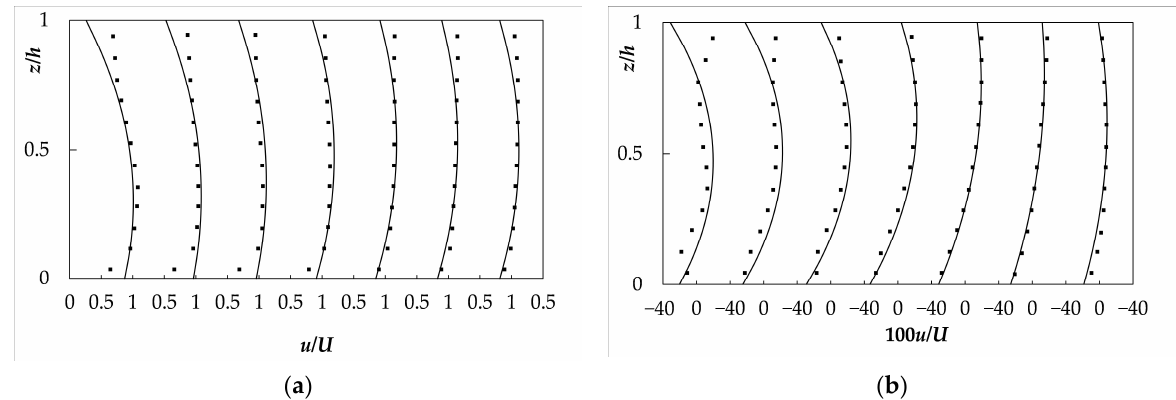
Figure 4. S180 cross section stream-wise velocities ( a ) and transversal velocities ( b ). The legend and locations are the same as in Figure 2.